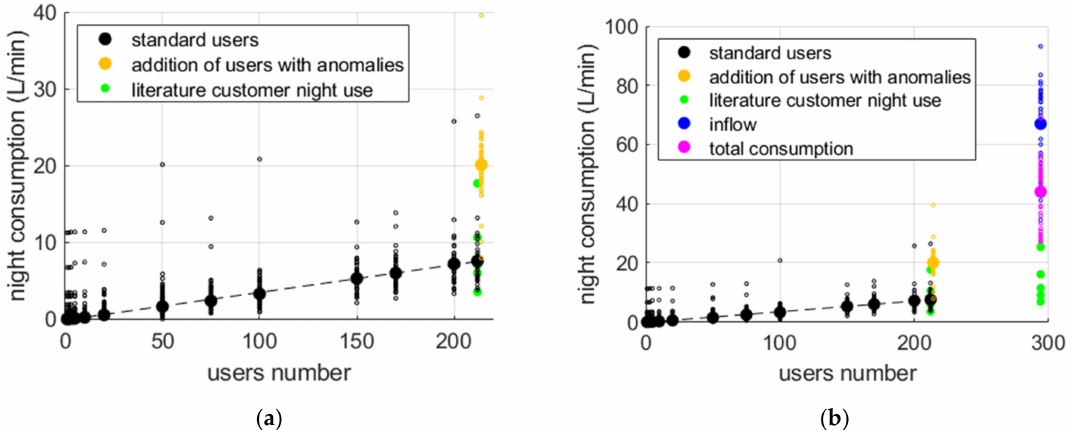
Figure 6. ( a ) Night consumption from set 1 (empty black dots) in L/min and their mean value (full black dots) fitted by a straight line, as well as values from set 2 (empty yellow dots) and their mean value (full yellow dots), compared with values from the literature (green dots). ( b ) Addition of minimum inflow (blue) and minimum total consumption (magenta) from set